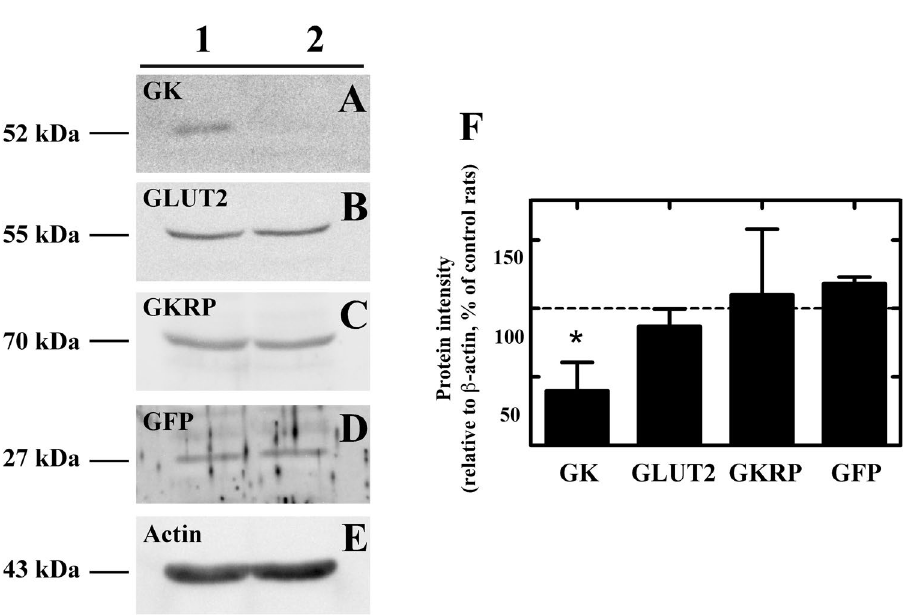
Figure 4. GK inhibition 48 h after AdshGK injection into the 3V. ( A ) Western blot assays of hypothalamic protein extracts in control (Ad-sh β Gal-injected rats) and Ad-shGK-injected rats using anti-GK, anti-GLUT2, anti-GKRP, and anti-GFP (transduction control) antibodies. An anti- β -actin antibody was used as loading control. Images are representative of three different experiments. ( B ) Densitometric analysis of each protein relative to β -actin evaluated in Ad-shGK-injected rats, as a percentage of this protein in Ad-sh β gal-EGFP- injected rats. Statistics: t-test with Welch correction * p <